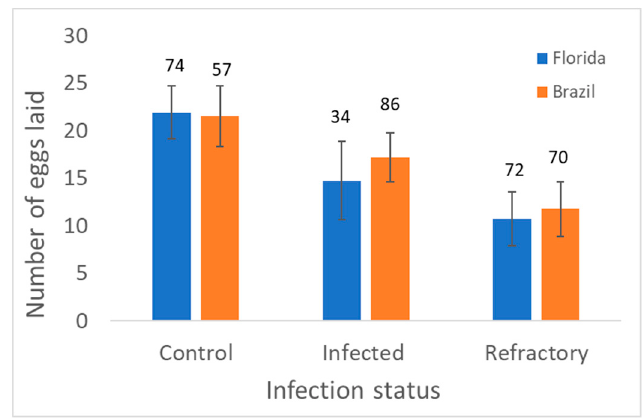
Figure 3. Least squares mean and standard error for the number of eggs laid by adult females in Control (unexposed) and MAYV-infected treatments (exposed) by infection status (infected or resistant / refractory) in Aedes aegypti . Numbers above bars show the number of female mosquitoes measured.